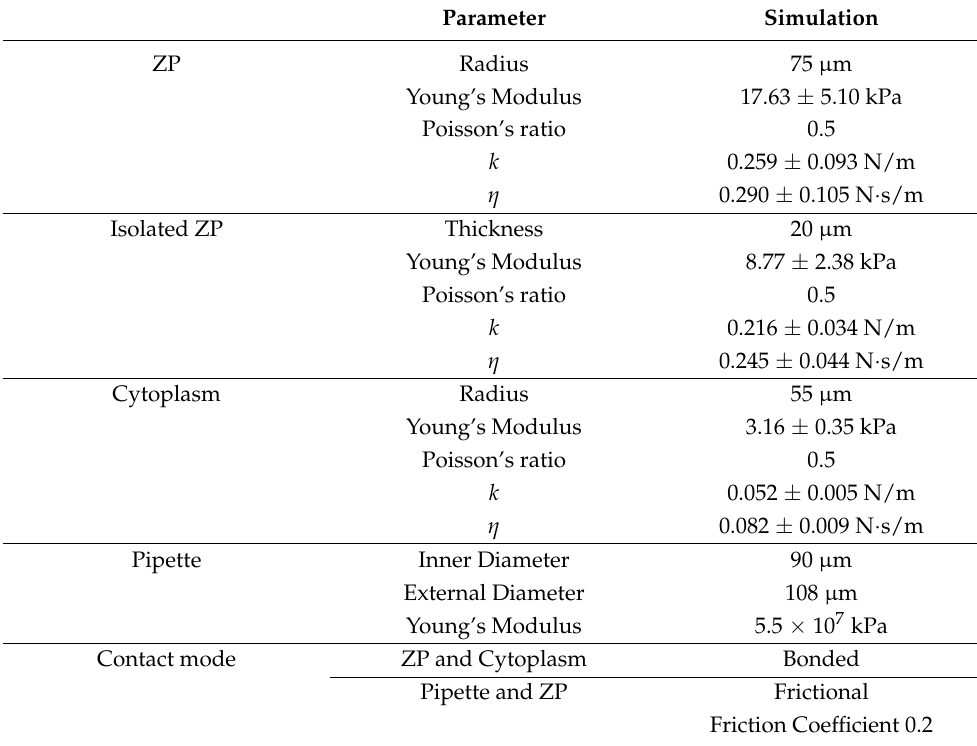
Table 1. A list of parameters used in cell